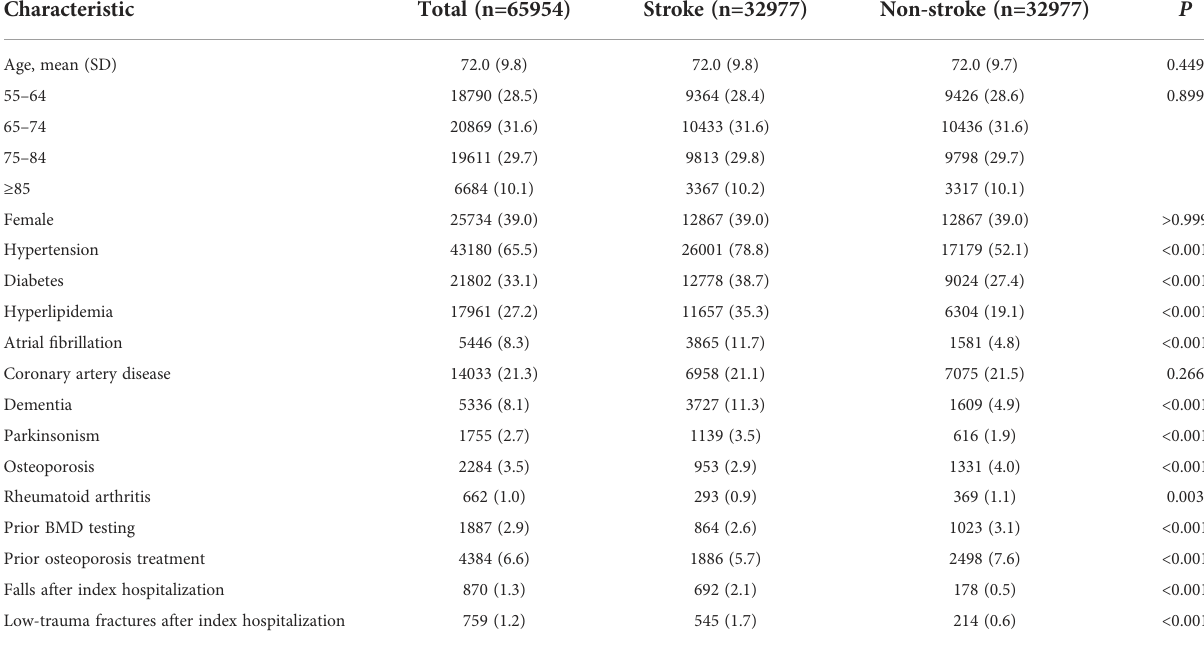
TABLE 1 Clinical characteristics of stroke patients versus non-stroke